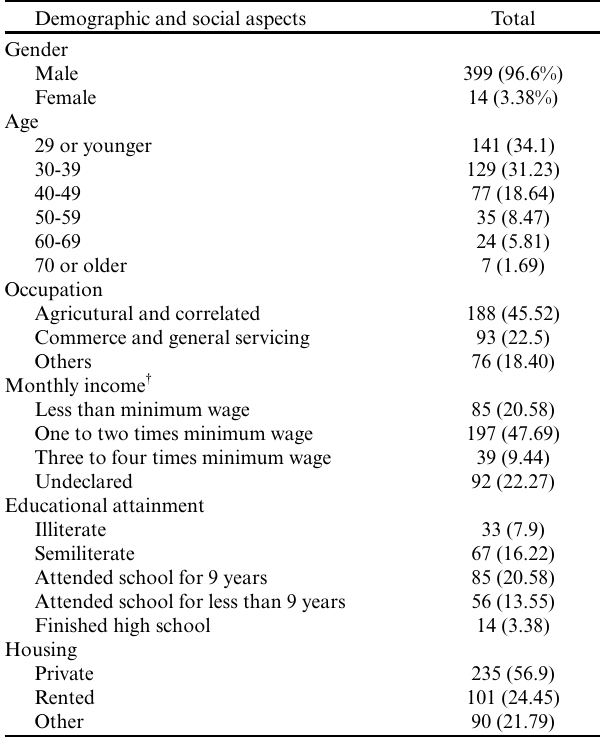
Table 1 . Information on educational attainment, age, income, and gender of